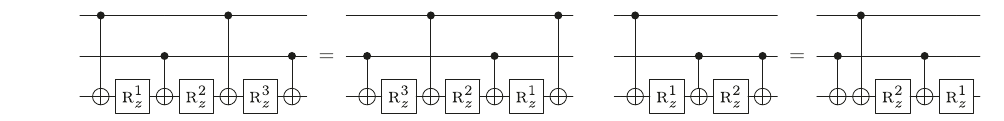
Fig. 6 Gate count preserving rewriting rules employed in Routine